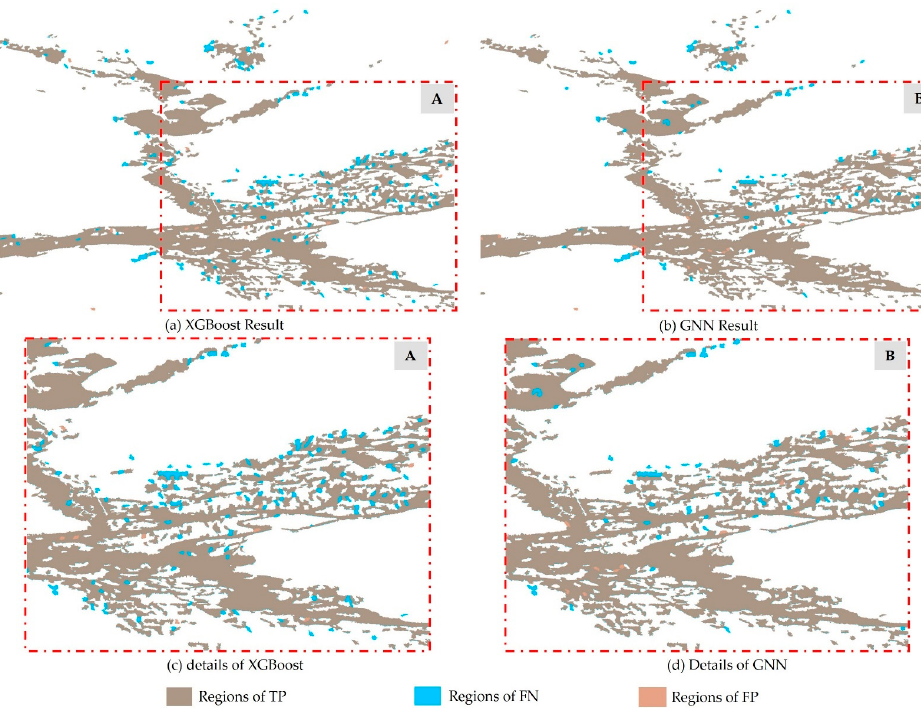
Figure 11. Comparison of XGBoost and GNN results (TP: true-positive; FN: false-negative; FP: false-positive; A: Rectangle A corresponding to details of XGBoost; B: Rectangle B corresponding to details of GNN).